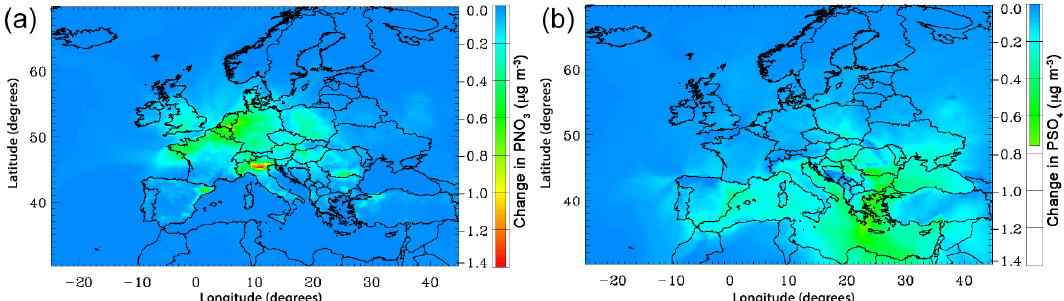
Figure 5. Change in PNO 3 (a) and PSO 4 (b) concentrations in June 2006 when BVOC emissions were doubled.